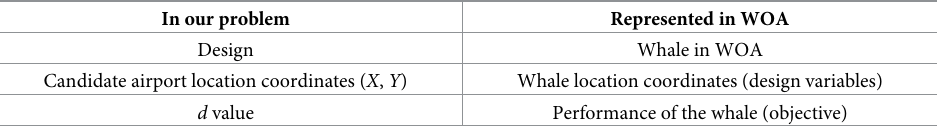
Table 2. Adapting the study to the